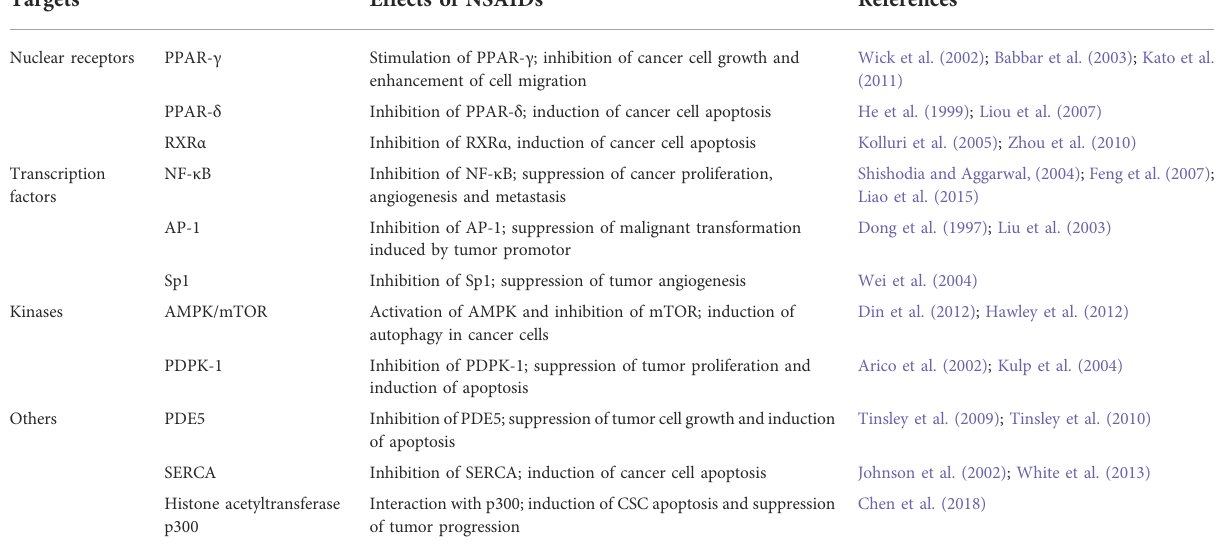
TABLE 2 COX-independent molecular targets of